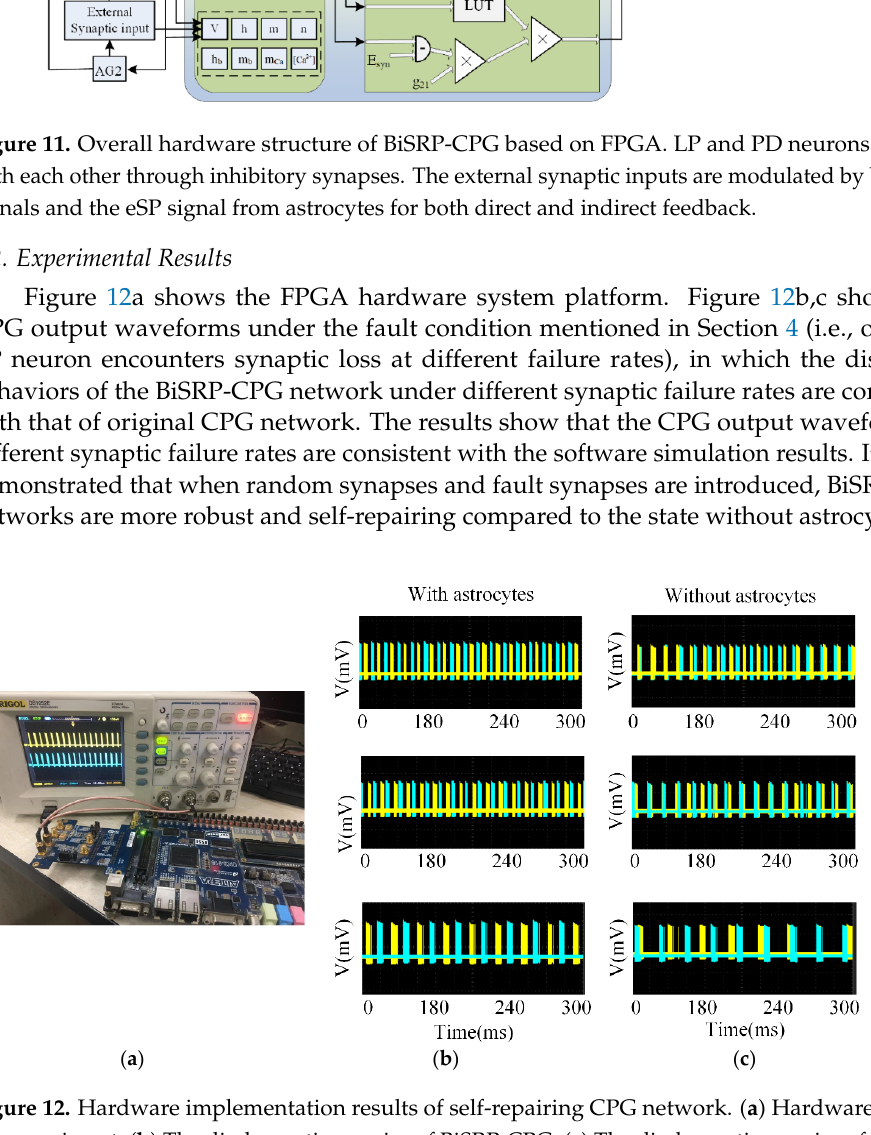
( c ) Figure 13. PR values and DSE signals at different failure rates, respectively: ( a ) 20% synaptic failure rate; ( b ) 30% synaptic failure rate; ( c ) 40% synaptic failure rate.